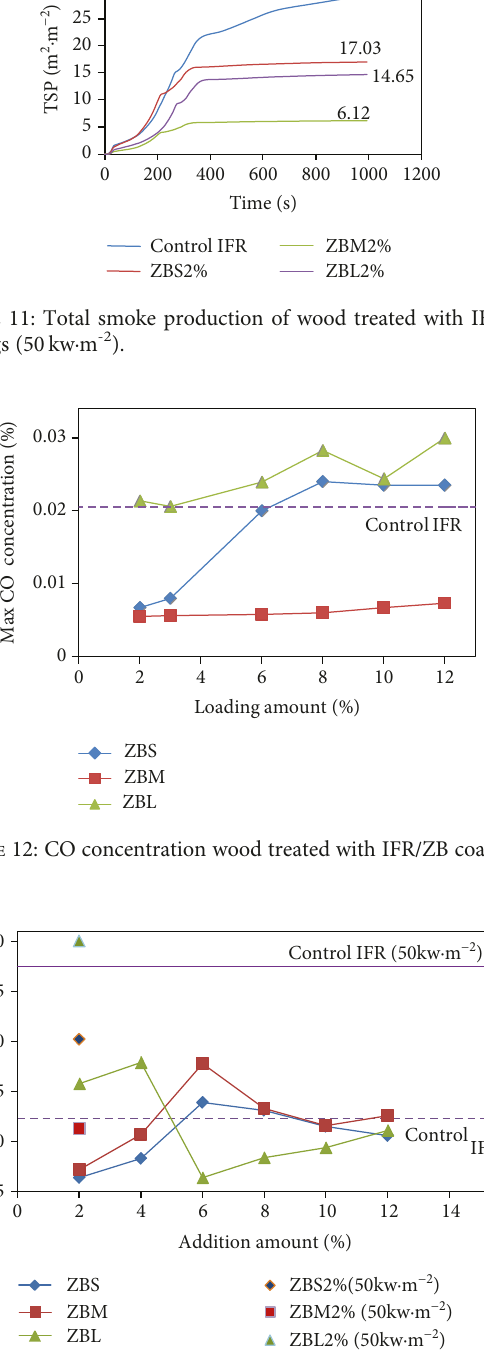
Figure 13: Mass loss of wood treated with IFR/ZB